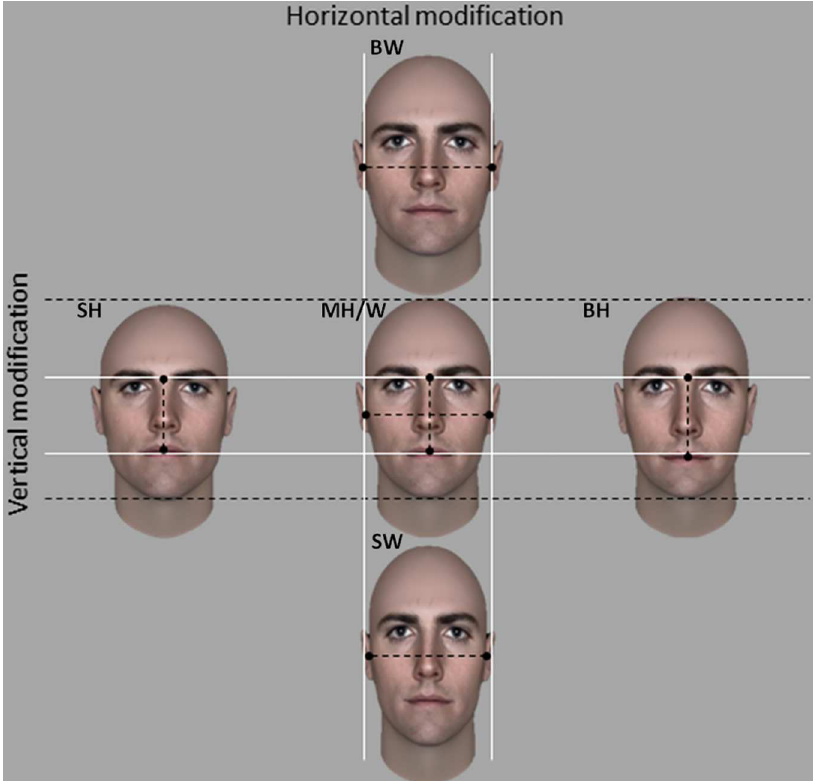
Fig 2. Vertical and Horizontal modification. Examplesof computer-generatedidentities modulated for the upper facial height (vertical modification) and byzigomatic width (horizontalmodification). From left to right, vertical modification: Small Height face (SH) corresponds to +3 in FaceGen Modeller (face-brown-chinratio); MiddleHeight face (MH), correspondsto 0 zero and Big Height face (BH) correspondsto -3. From top to bottom, horizontal modification: Big Wide (BW), MiddleWide (MW), Small Wide faces